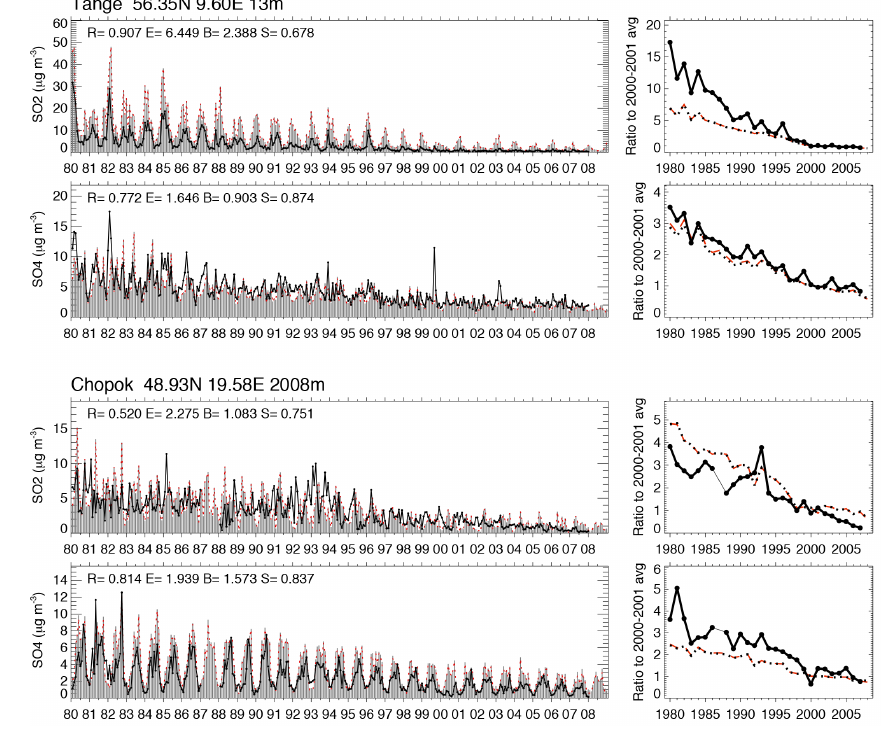
Fig. 8b. Left column: monthly averaged surface SO 2 and sulfate concentrations (µgm − 3 ) from 1980 to 2008 at two European sites, Tange in Denmark (top two rows) and Chopok in Slovakia (bottom two rows). Data from the EMEP network. Observations are shown in black lines and the model results in grey bars for total amount and dotted red lines for FF + BB amount. Statistical measures ( R , E , B , and S ) are defined as the same as in Fig. 7 caption. Right column: corresponding ratio of annual mean concentrations to the 2000–2001 average showing the interannual variability/trend over the 20-year period with the observation and models in solid and dotted lines, respectively. Thin solid black line in the right column connects the points with missing year(s) in between for visual continuity.